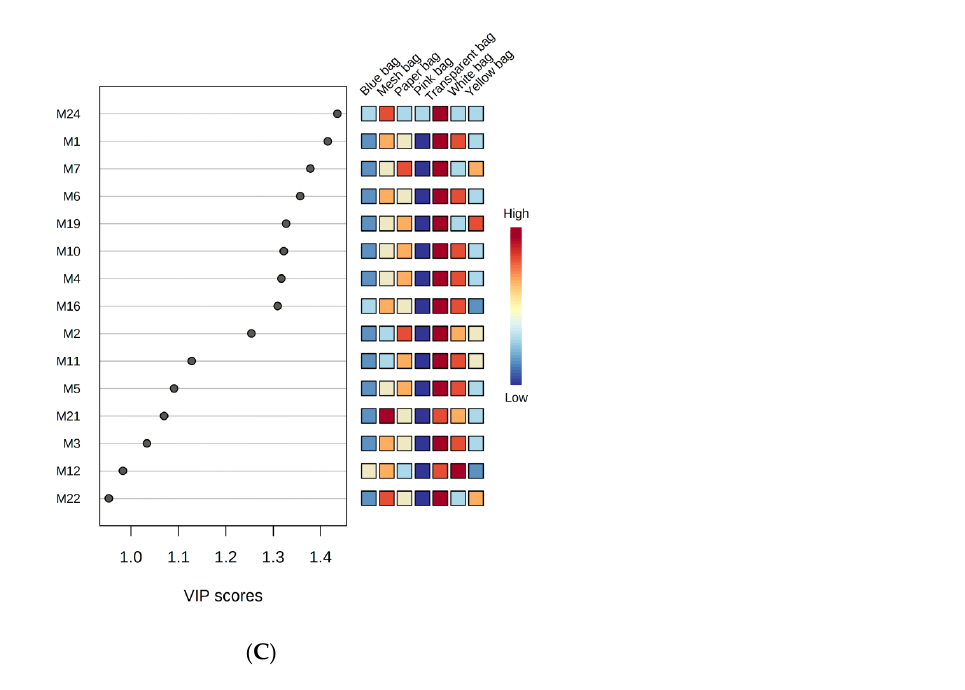
Figure 5. Main compounds based on VIP value under fruit bagging treatment with different types of bags in three table grape cultivars (( A ): RDZH; ( B ): RDHY; and ( C ): RDHM).